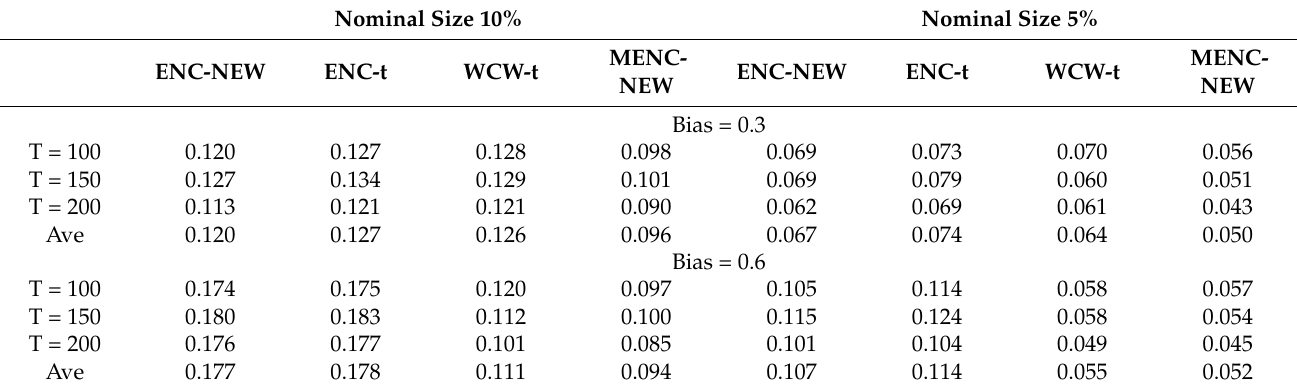
Table 4. Empirical Size for P/R =